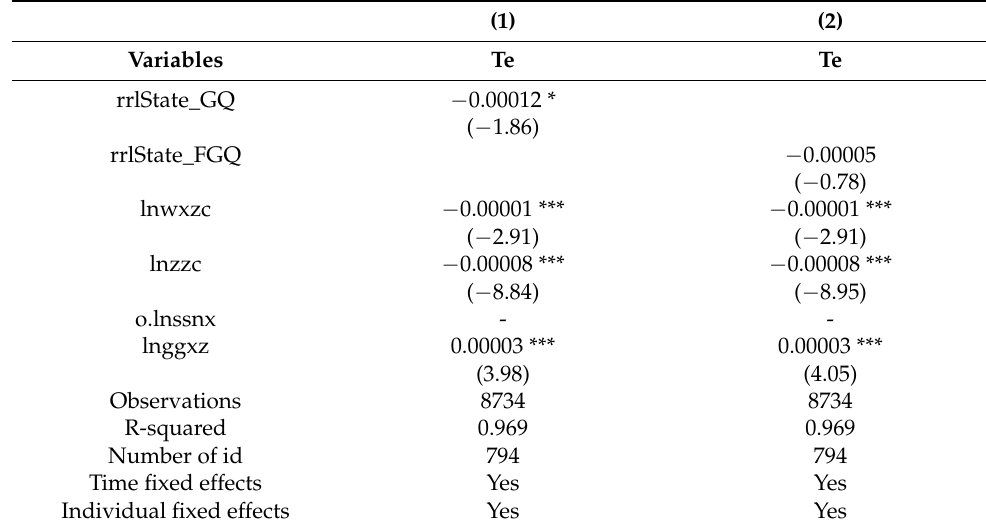
Table 9. Heterogeneity analysis on the nature of enterprise ownership based on IV